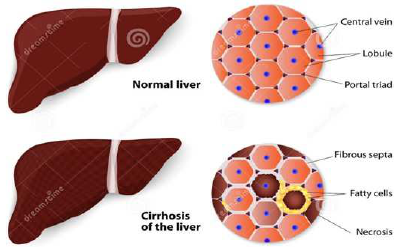
Fig. 2 Structure of Normal Liver and cirrhosis Liver(From Dreamstime.com